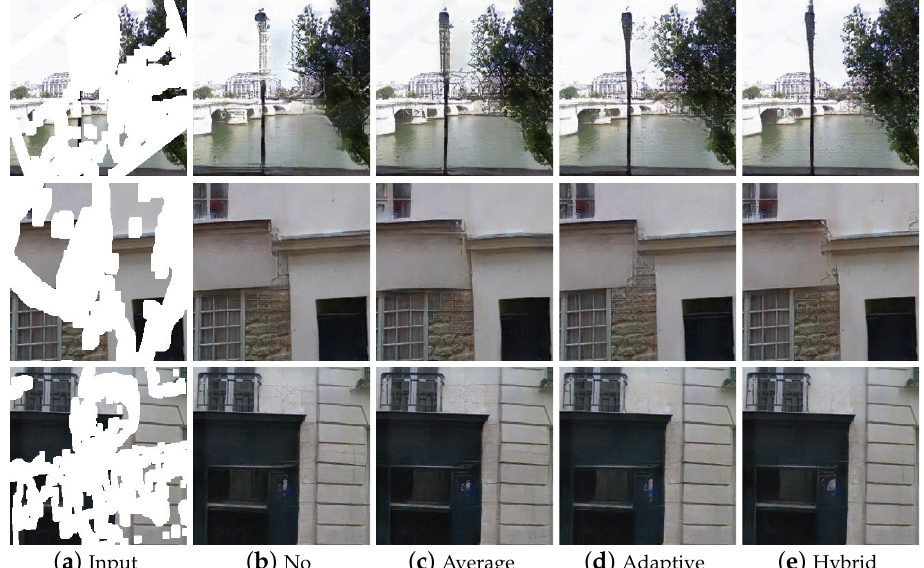
Figure 10. Different methods for feature merging. From the left to the right are: ( a ) Input, ( b ) No merging, ( c ) Average merging, ( d ) Adaptive merging, ( e ) Hybrid